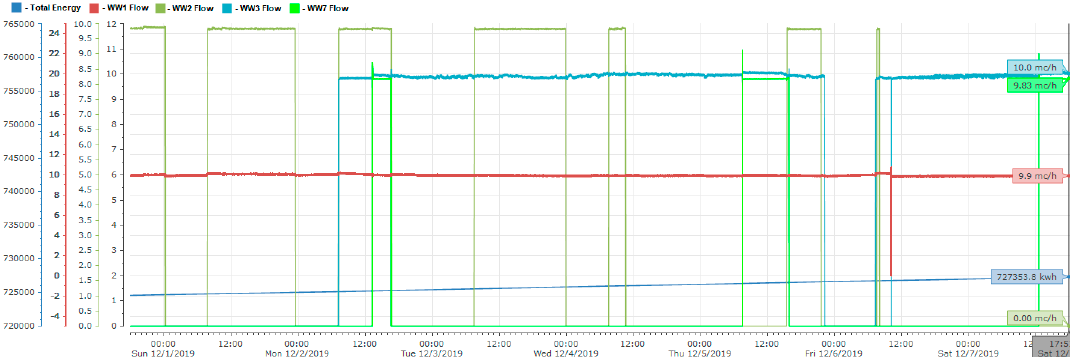
Figure 12. Results with constrained FDC. Well flows (mc/h) and energy consumption (kWh) in Week 2 of tests.